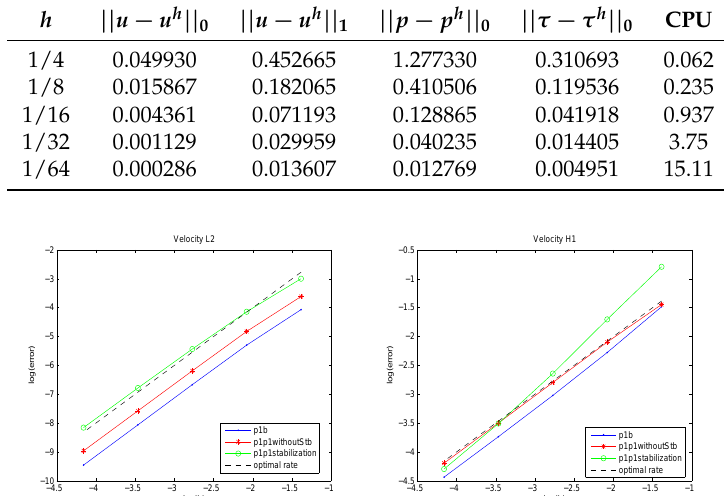
Figure 1. A pictorial representation of convergence rate by using the lowest equal order FE triples for the pressure L 2 ( left ); for the velocity H 1 ( right ).